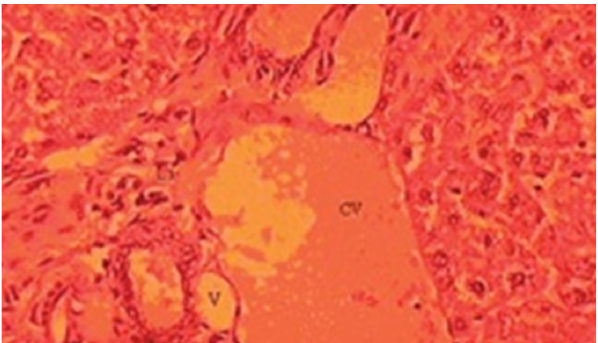
Fig. 3. Transverse section of the liver of a rat treated with lead acetate showing congestion of central vein, vacuolization, leuco- cytic infiltration, pyknotic nuclei, and loss of radial arrangement of hepatocytes